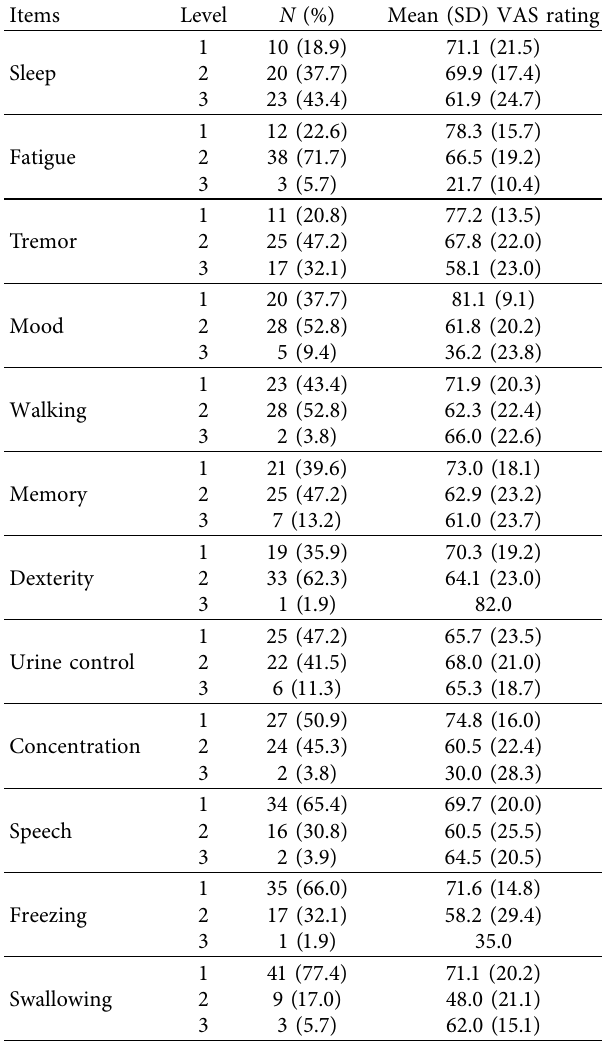
Table 4: Mean (SD) VAS rating for each item response option. Items